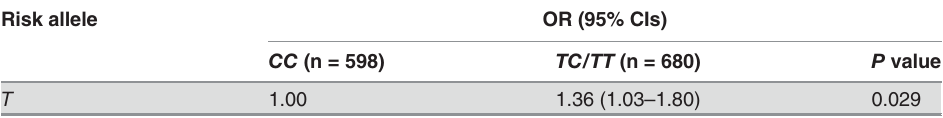
a Adjusted for age, sex, body mass index, smoking, total cholesterol, triglyceride, diastolic blood pressure and education. the history of using statins.